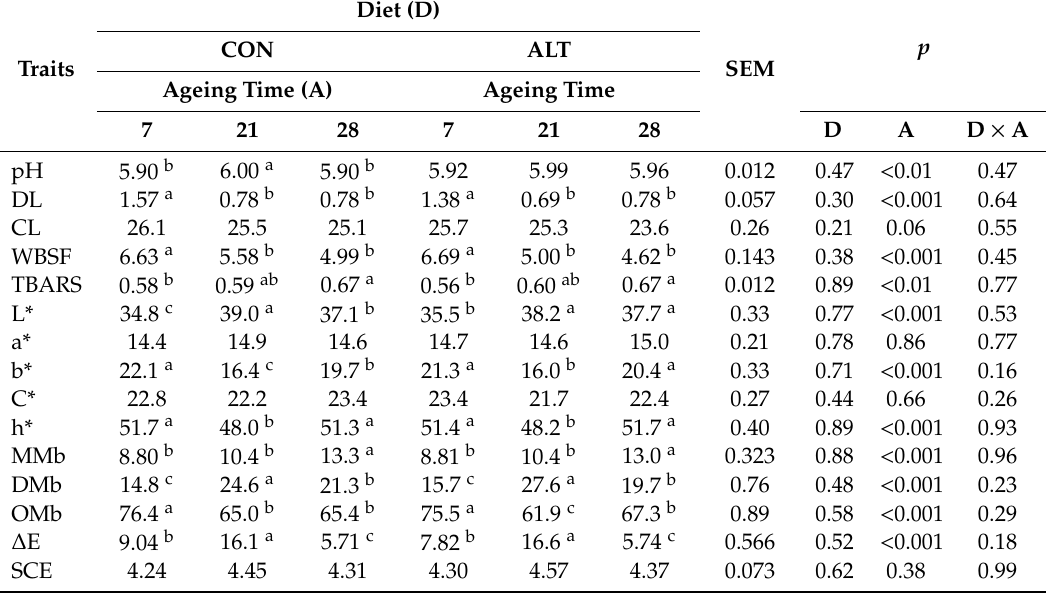
Table 4. Values of pH, drip loss (DL), cooking loss (CL, %), Warner–Braztler shear force (WBSF, kg / cm 2 ), thiobarbituric acid reactive substances (TBARS, mg malonaldehyde / kg meat), colour traits (L*, lightness; a*, redness; b*, yellowness; C*, chroma; h*, hue), colour variation ( ∆ E), surface colour stability (SCE) and pigment contents (MMb, metmyoglobin; DMb, deoxymyoglobin; OMb, oxymyoglobin; all in % of total pigments) of meat from crossbred Limousine heifers finished on a conventional